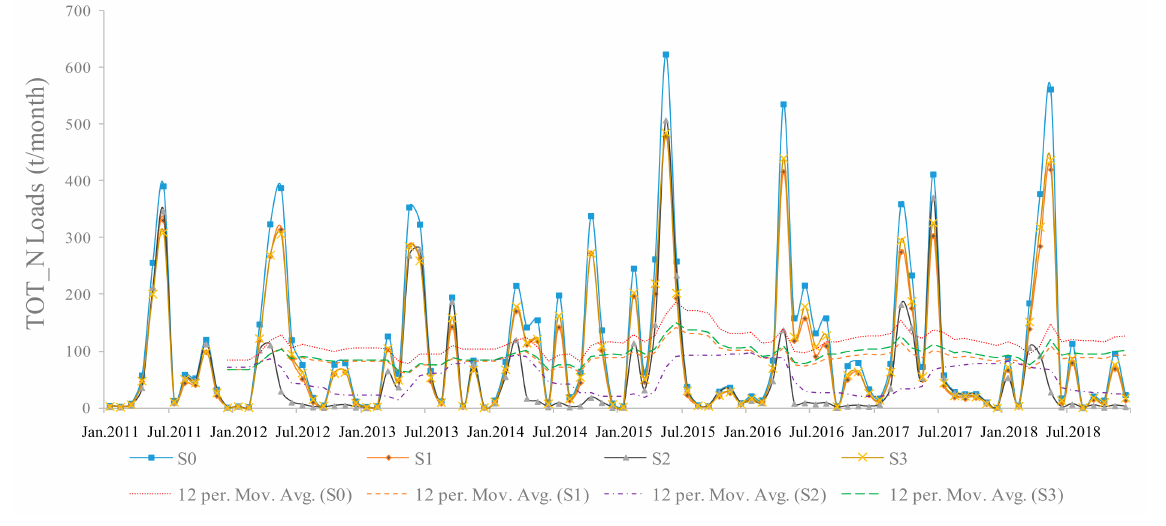
Figure A1. Simulation of monthly TOT_N load in MLW under different scenarios.